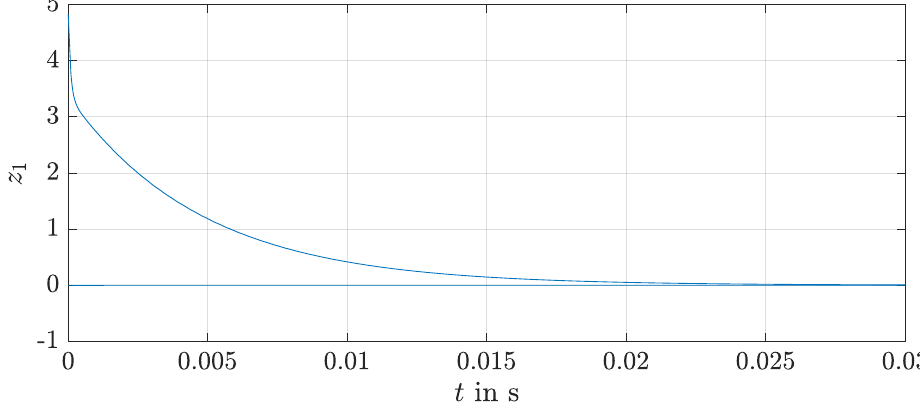
Figure 8. Prediction of the state variable z 1 in transformed coordinates.